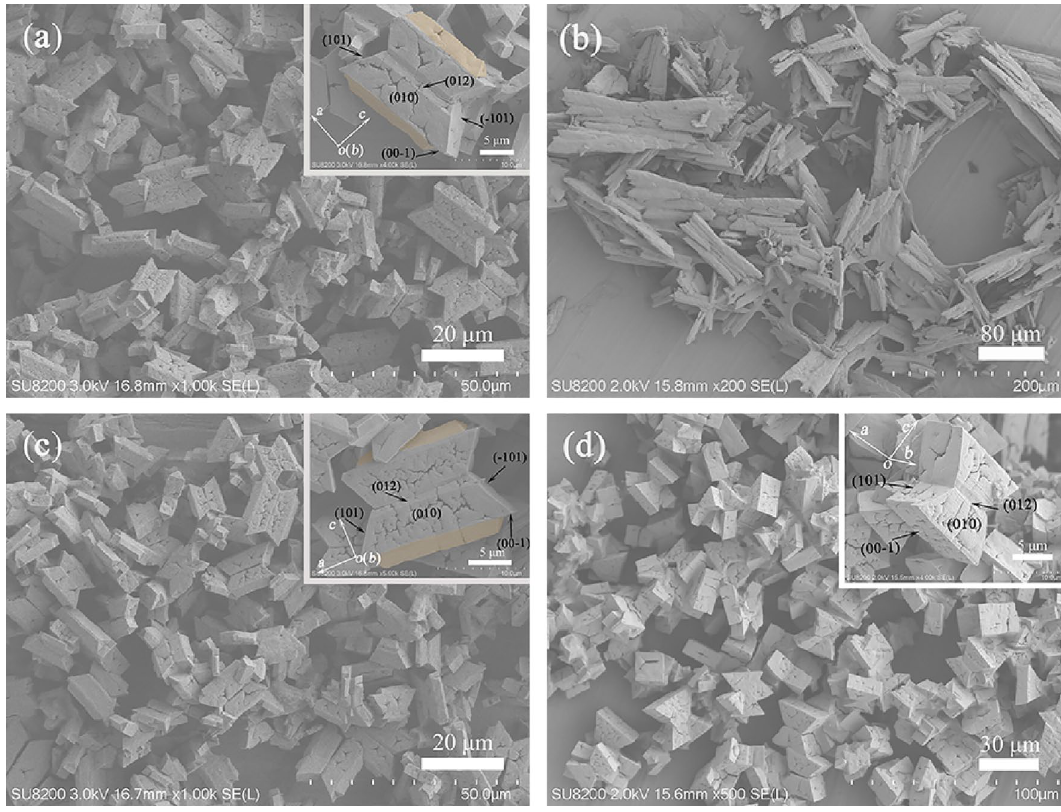
Figure 3. Representative FESEM images of the samples biomimetically synthesized for 30 min with unseparated liquid culture ( a ), bacterial cells ( b ), supernatant ( c ), or uninoculated culture medium ( d